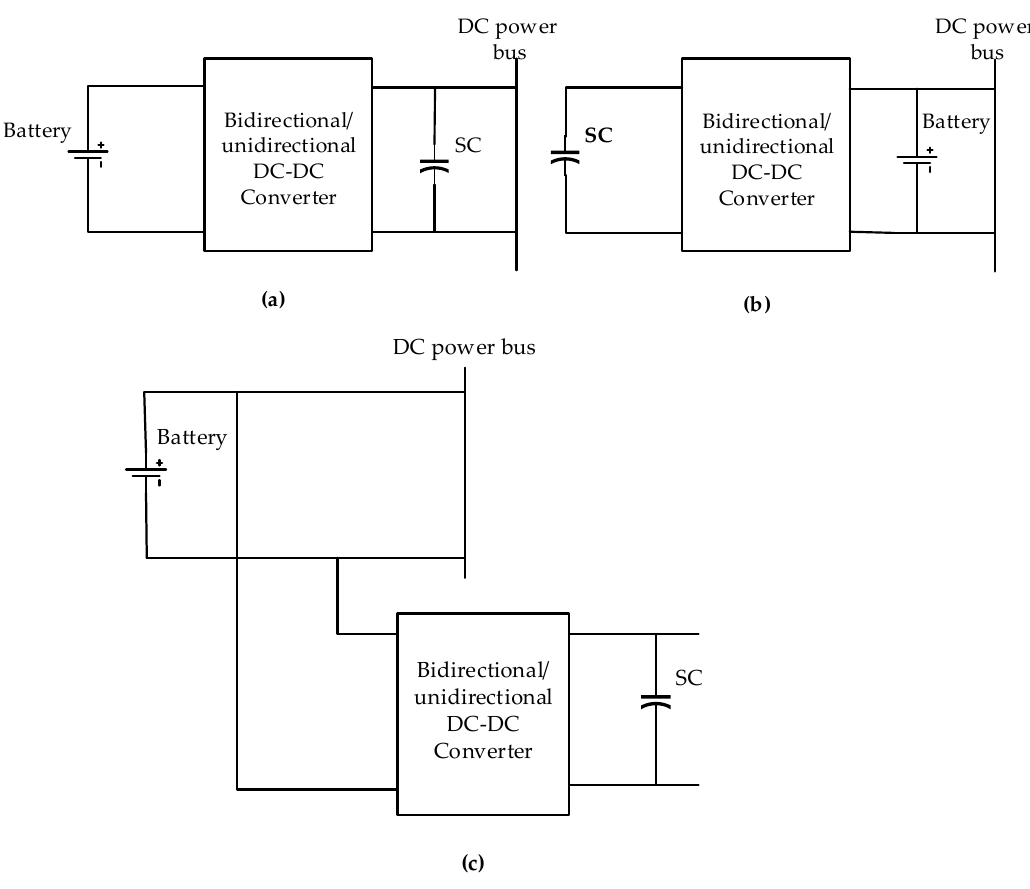
Figure 9. Different types of semi-active topologies in HESS; ( a ) battery-converter-SC; ( b ) SC battery-converter; ( c ) hybrid battery SC.